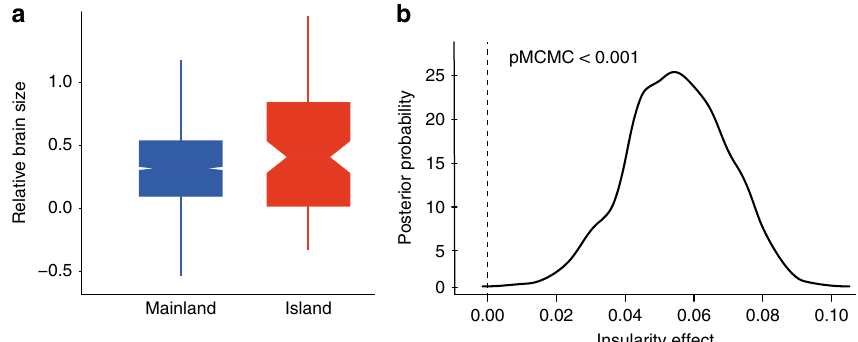
Fig. 1 The effect of insularity on relative brain size. a Oceanic island birds have relatively bigger brains than other birds (boxplots represent median and percentiles [2.5, 25, 75 and 97.5 %]). b From the posterior samples of the BMPP models, we can see a consistent effect of insularity on relative brain size across phylogenies coming from two different backbones from the global avian